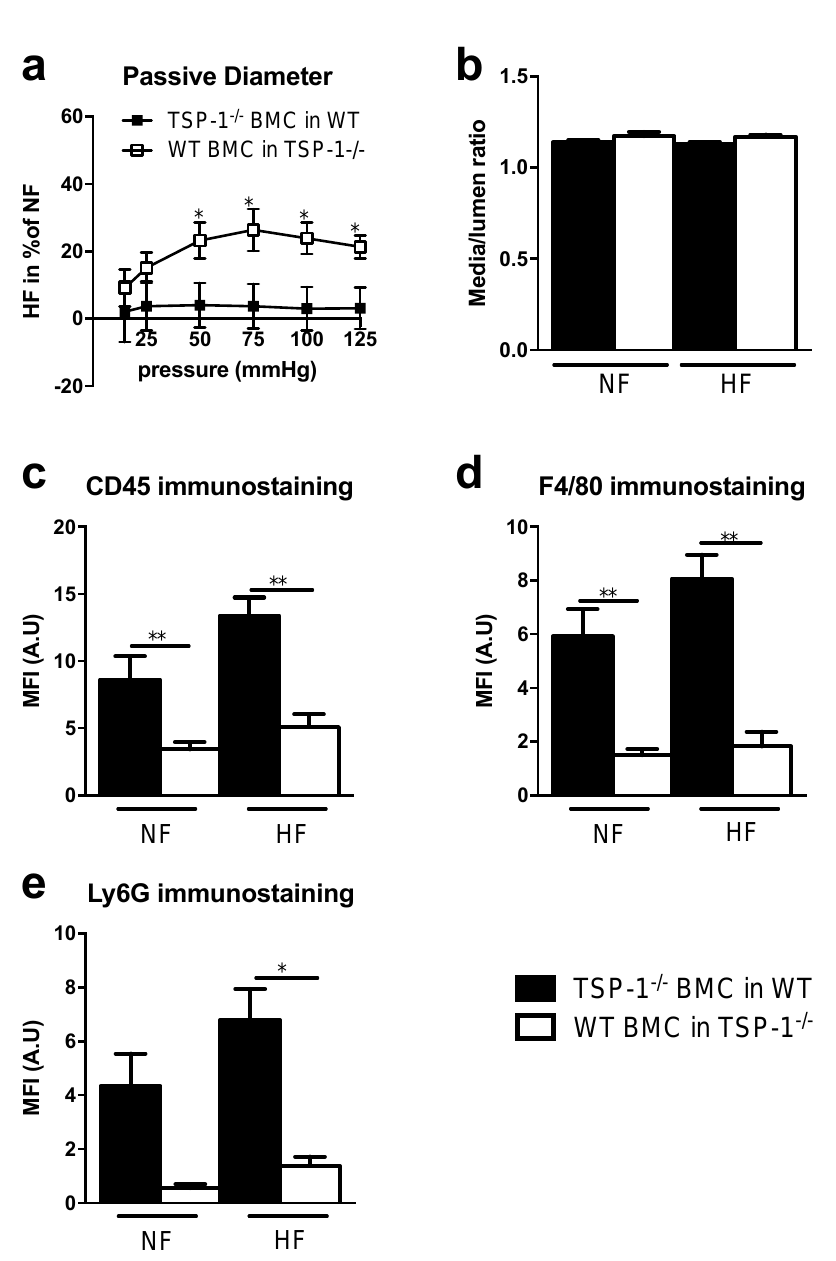
Figure 2. Remodeling study after seven days of chronic increase in blood flow and BMC transfer experiments. Graphs show ( a ) the passive diameter of HF mesenteric arteries in percent of NF mesenteric arteries diameter, ( b ) histomorphometry analysis of these arteries as media-to-lumen ratio. TSP-1 − / − BMC in WT, n = 9 and WT BMC in TSP-1 − / − , n = 9. The mean fluorescence intensity (MFI) of the peri arterial zone representing the total immune cells ( c ), the macrophages ( d ) and the neutrophils ( e ) is measured after four days of ligature in TSP-1 − / − BMC in WT ( n = 5) and in WT BMC in TSP-1 − / − ( n = 7). TSP-1 − / − BMC in WT arteries are represented in black and the WT BMC in TSP-1 − / − in white. All results are expressed in means ± sem. * p < 0.05, ** p < 0.01, TSP-1 − / − BMC in WT vs. WT BMC in TSP-1 − / −